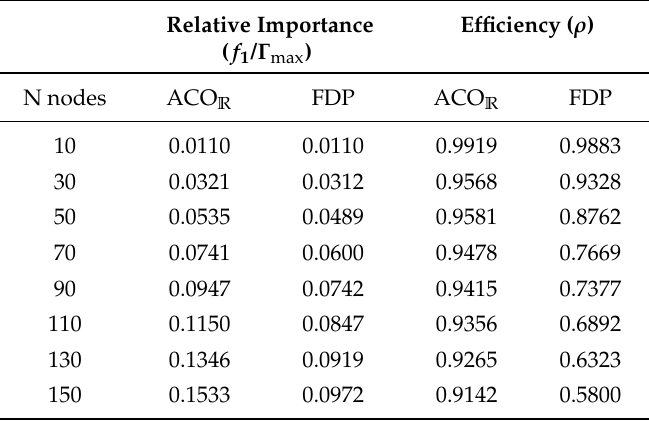
Table 3. Maximum joint-coverage in